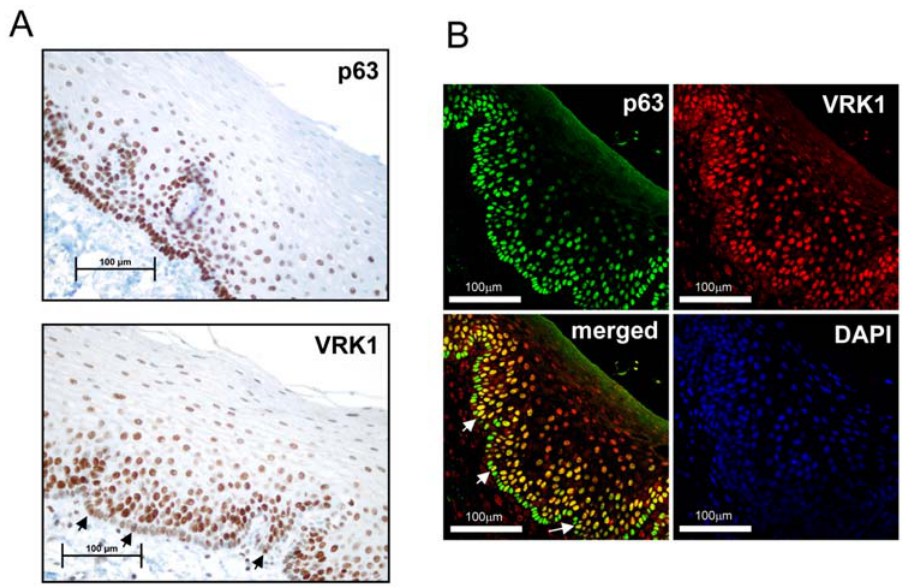
Figure 8. Localization of VRK1 and p63 in the squamous epithelium of the human pharynx. (A). Immunohistochemistry detection of p63 and VRK1 proteins in the pharynx. The arrows indicate cells (3 out of 56) in the basal layer with higher levels of VRK1. The p63 was detected with a monoclonal antibody. VRK1 was detected with the VC1 polyclonal antibody. (B). Immunofluorescence of p63 and VRK1 in the human pharynx epithelium. The arrows indicate cells (3 out of 57) in the basal layer that have higher levels of